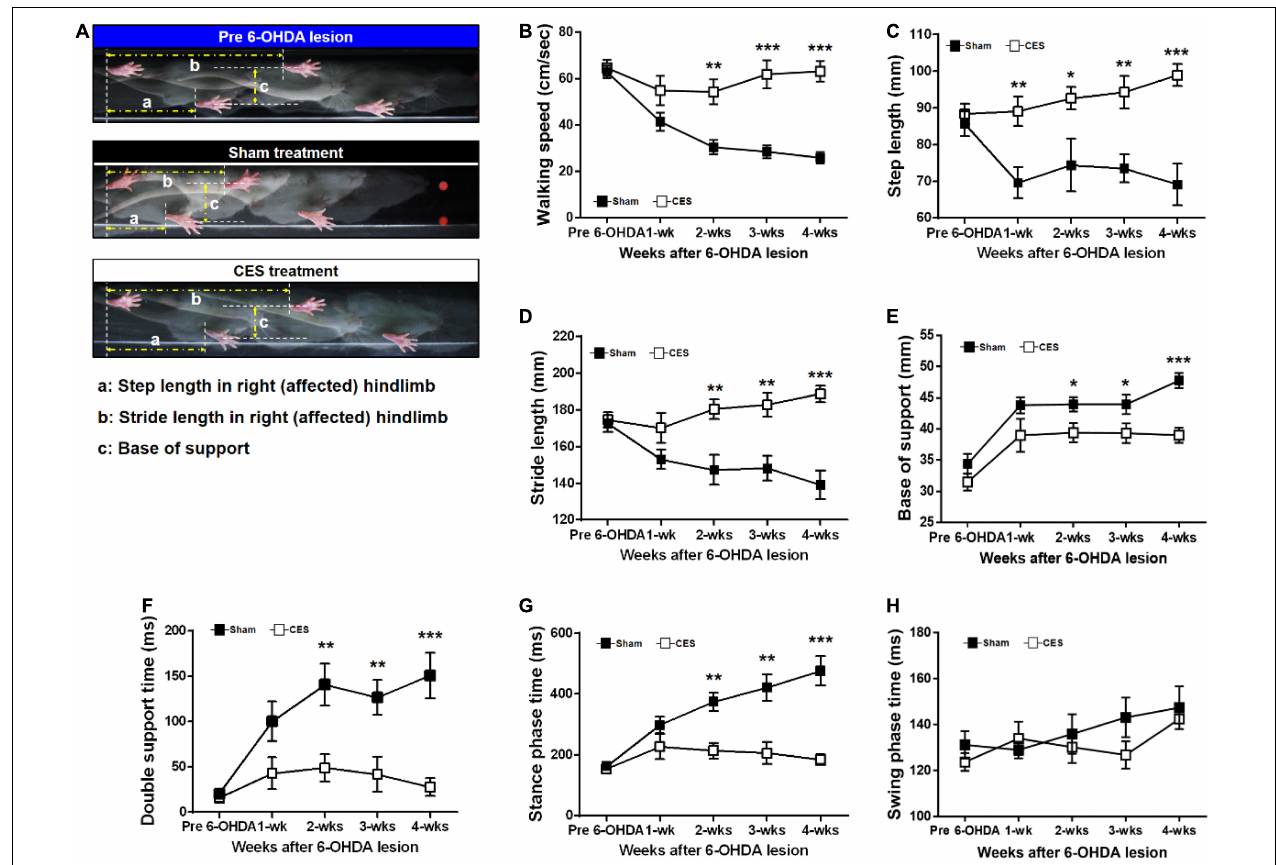
FIGURE 5 | (A) Characteristics of stepping of rat (as indicated by footprints) during walkway locomotion prior to PD lesion and postlesion week 4 for a sham treatment group rat and a CES-treated rat. Time-course changes in walking speed (B) , step length (C) , stride length (D) , base of support (E) , double support time (F) , stance phase time (G) , and swing phase time (H) in the sham-treated and CES-treated PD rats over the 4 weeks of observation. Notably, the walking speed, step, and stride lengths decreased significantly in the sham CES treatment group but were less affected in the CES treatment group. Gradual increases in the base of support were found in both groups, but the CES treatment group exhibited a lower increase than the sham treatment group. * p < 0.05, ** p < 0.01, and *** p < 0.001, each of which indicated significant differences between two groups at each time point (unpaired t